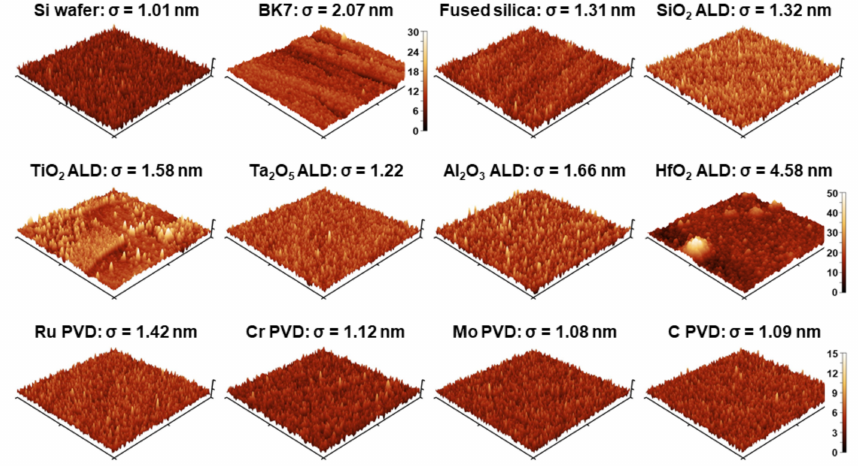
Figure 9. Atomic force microscope (AFM) images of Ir coatings with 800 ALD cycles (corresponding to 50–60 nm layer thickness) on different substrate materials. For all images, the root-mean-square (rms) surface roughness of these 2 × 2 µ m 2 sample areas is calculated. The color bar in the bottom right corner from 0–15 nm is valid for all images, except for BK7 and HfO 2